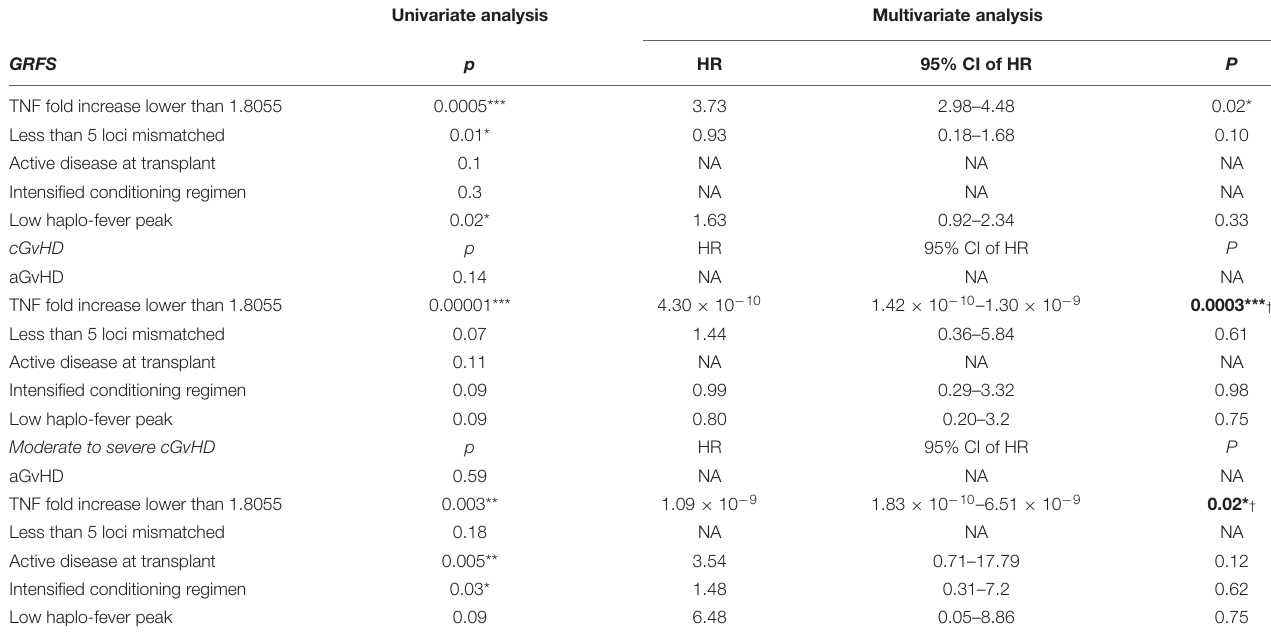
TABLE 4 | The univariate and multivariate analysis of transplant outcomes.